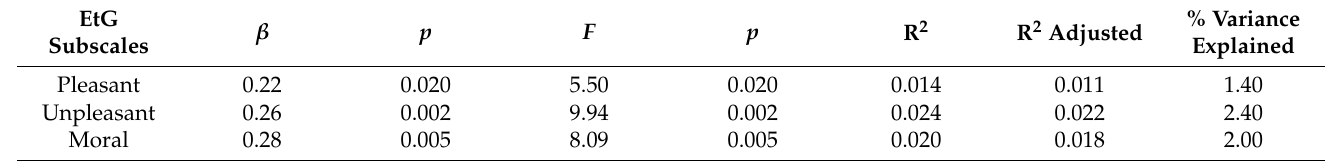
Table 11. Regression coefficients and models predicting EtG subscales by Asian